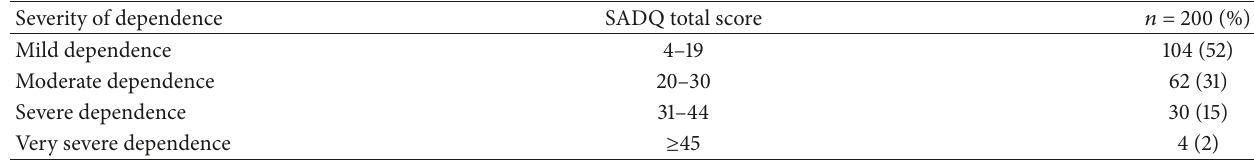
Table 2: Classification of alcohol dependent patients based on severity.